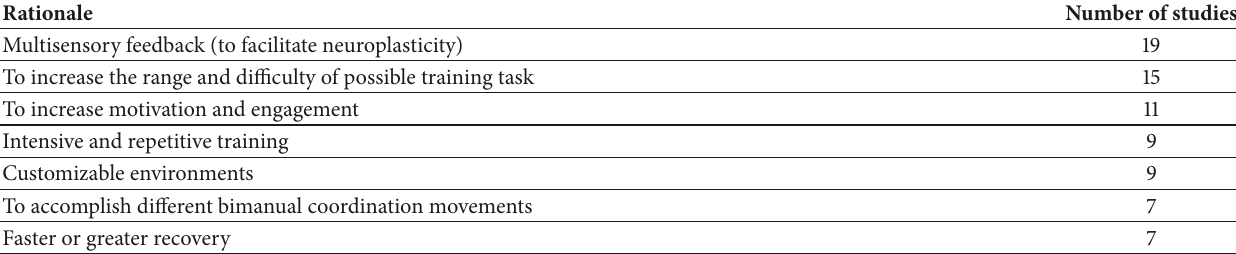
Table 6: Rationale cited in the studies for conducting research on mirror robotic systems or mirror virtual reality rather than standard mirror